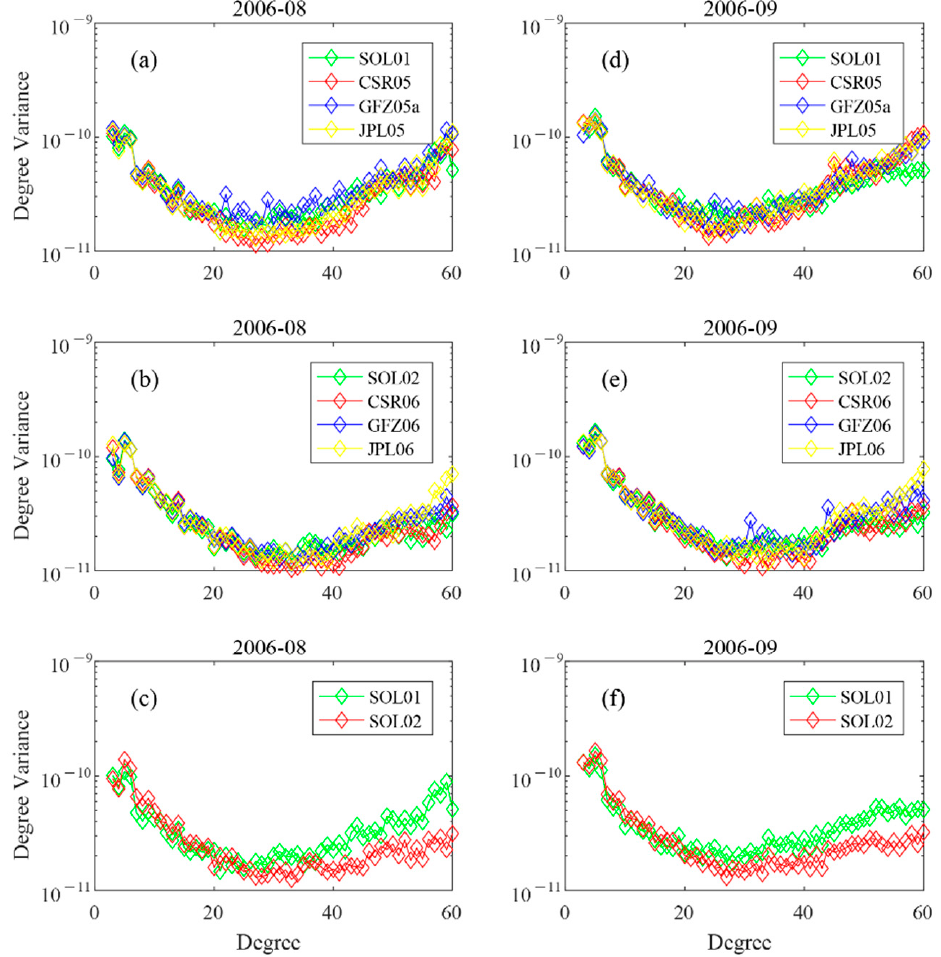
Figure 7. Comparison of the monthly gravity field solution degree variances of SOL01 and SOL02 from d/o 3 to 60 in August 2006 and September 2006. ( a ) SOL01/CSR05/GFZ05a/JPL05 in August 2006, ( b ) SOL02/CSR06/GFZ06/JPL06 in August 2006, ( c ) Comparison of SOL01 and SOL02 degree variances in August 2006, ( d ) SOL01/CSR05/GFZ05a/JPL05 in September 2006, ( e ) SOL02/CSR06/GFZ06/JPL06 in September 2006, and ( f ) Comparison of SOL01 and SOL02 degree